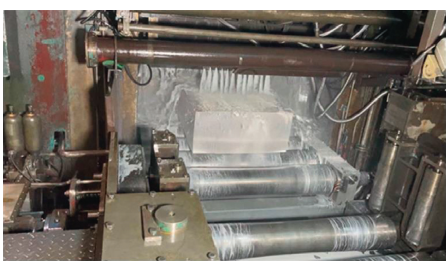
Figure 4: Rolling